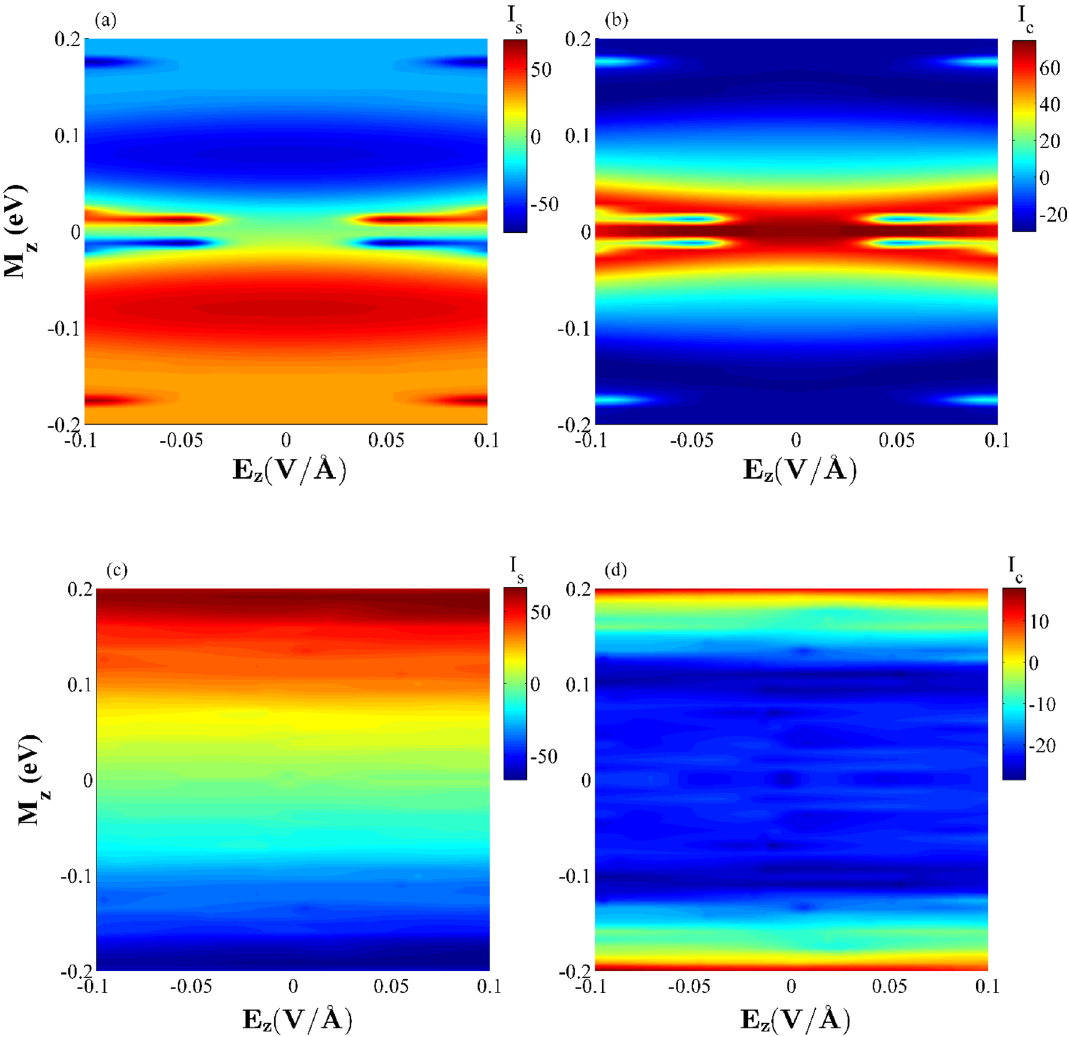
Figure 11. The combined effects of ferromagnetic exchange fields, M z , and external electric fields ( E z and E y G , E y S ) on the net spin current ( I S ) and total electron current ( I C ) for the considered hybrid GSNR and ( a , b ) E y G = E y S = 0 ( c , d ) E y G = 0.913 V/Å, E y S = 0.127 V/Å. The results are for T R = 358 K and ∆ T = 20 K. I S and I C have nA units in all